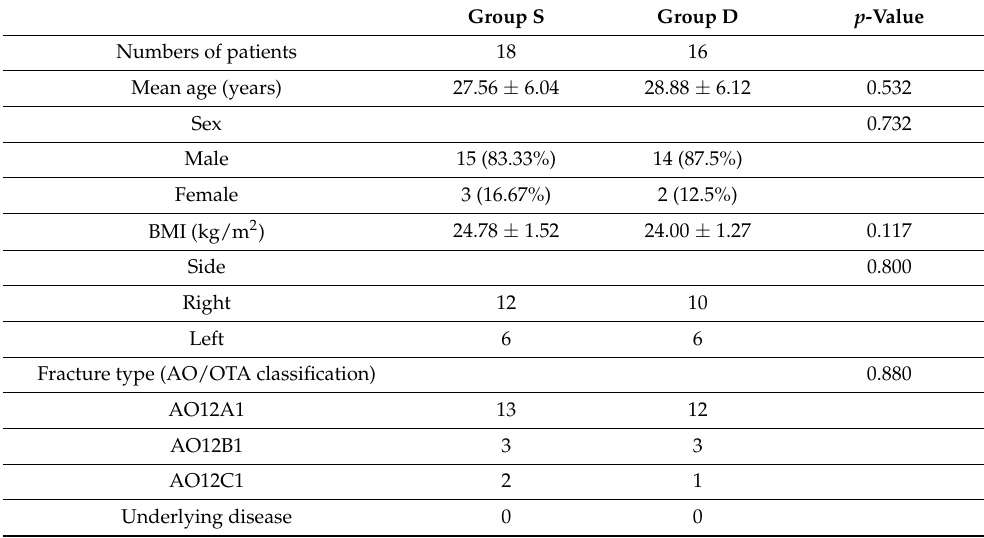
Abbreviations: BMI = body mass